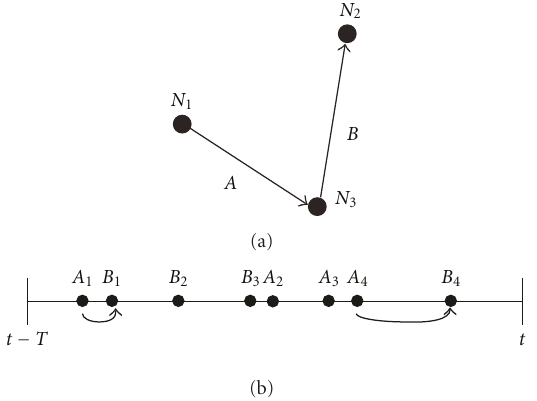
Figure 1: (a) simple 3 nodes network with intermittent links. (b) temporal occurrence of the